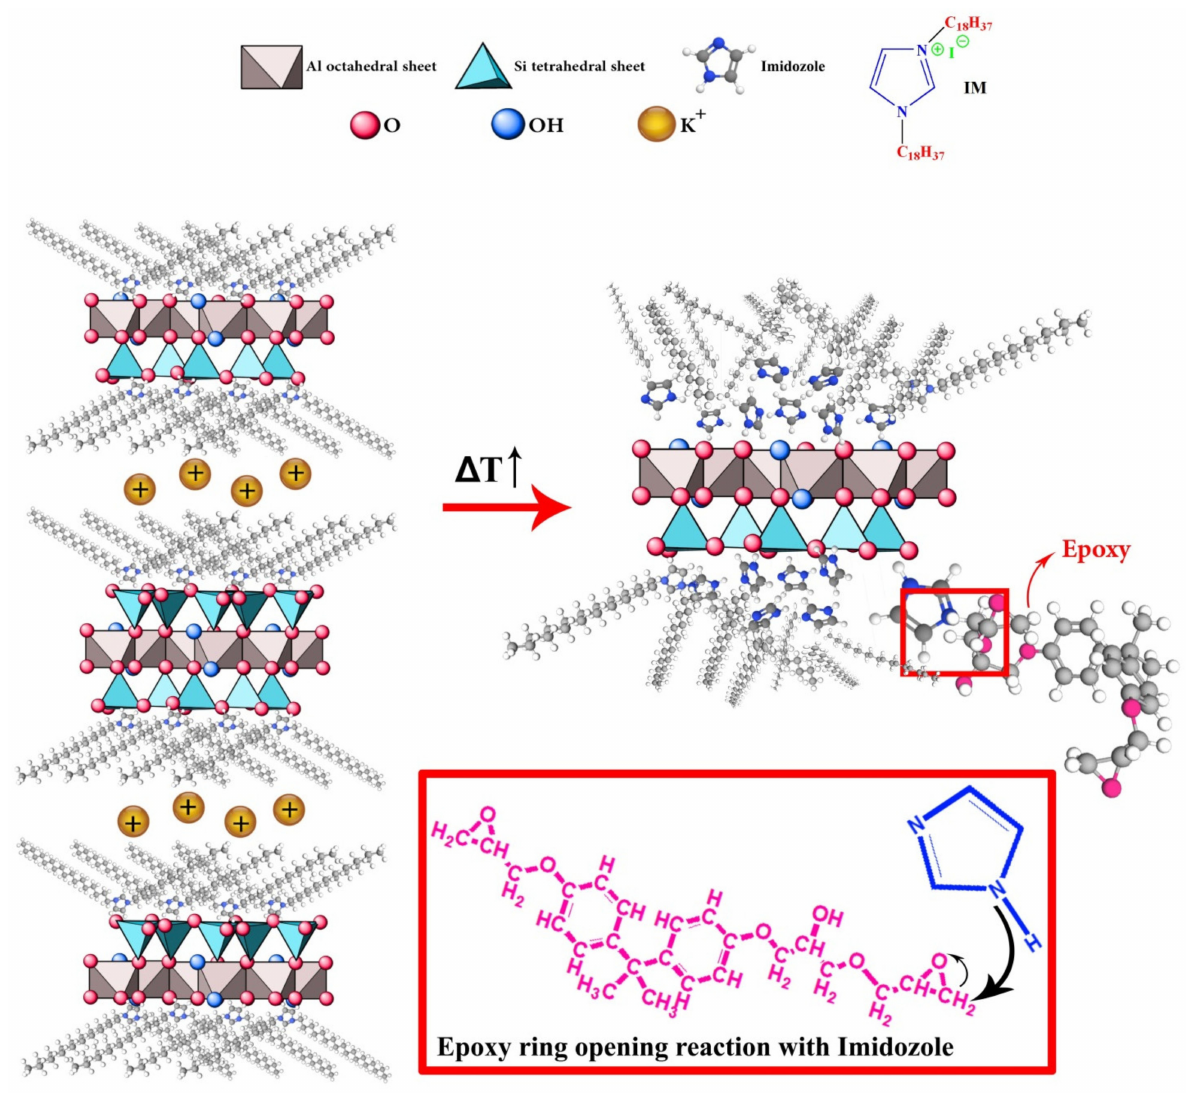
Figure 7. Schematic of interaction between the functionalized Mica (Mica-IM) and epoxy